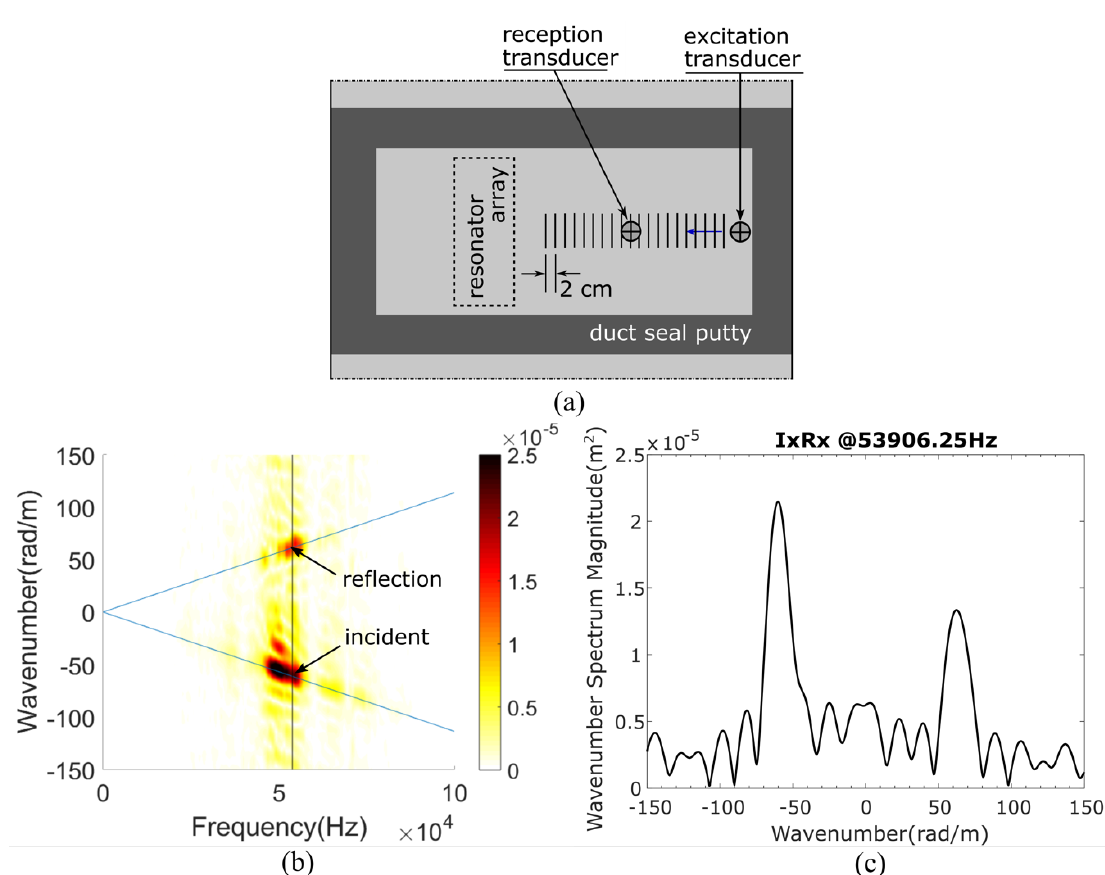
Figure 6. ( a ) Schematic of transducer positioning with respect to the resonator array for measuring reflected waves; ( b ) The 2DFFT of the incident/reflection measurements. The diagonal blue lines are the dispersion curves for the forward and backward propagating S0 Lamb wave. The vertical black line is where the wavenumber-spectrum slice data at a frequency of 53.9 kHz are obtained for ( c ) the wavenumber spectrum.